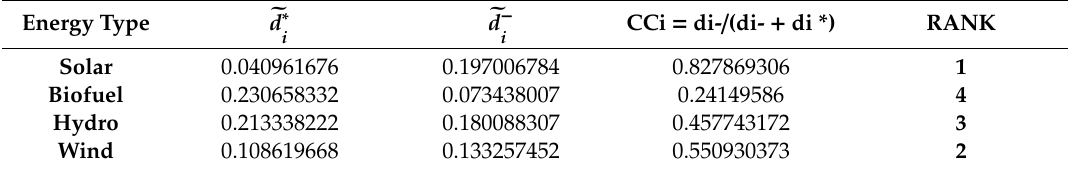
Table 13. Ranking of the energy alternative